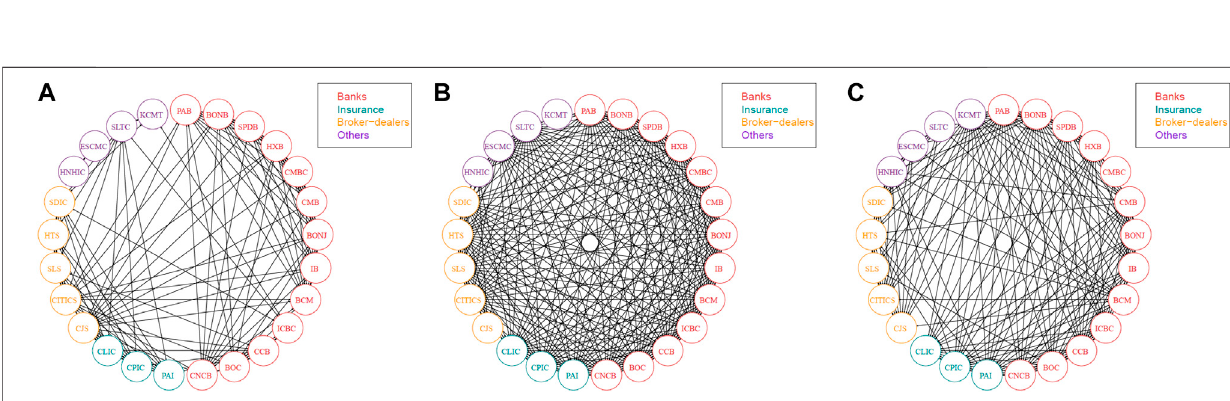
FIGURE3| SystemicriskdependencenetworksoftheUSSIFIsacrossthethreestages. (A) Stage1(17October2006) (B) Stage2(20December2007) (C) Stage 3 (28 January 2013).